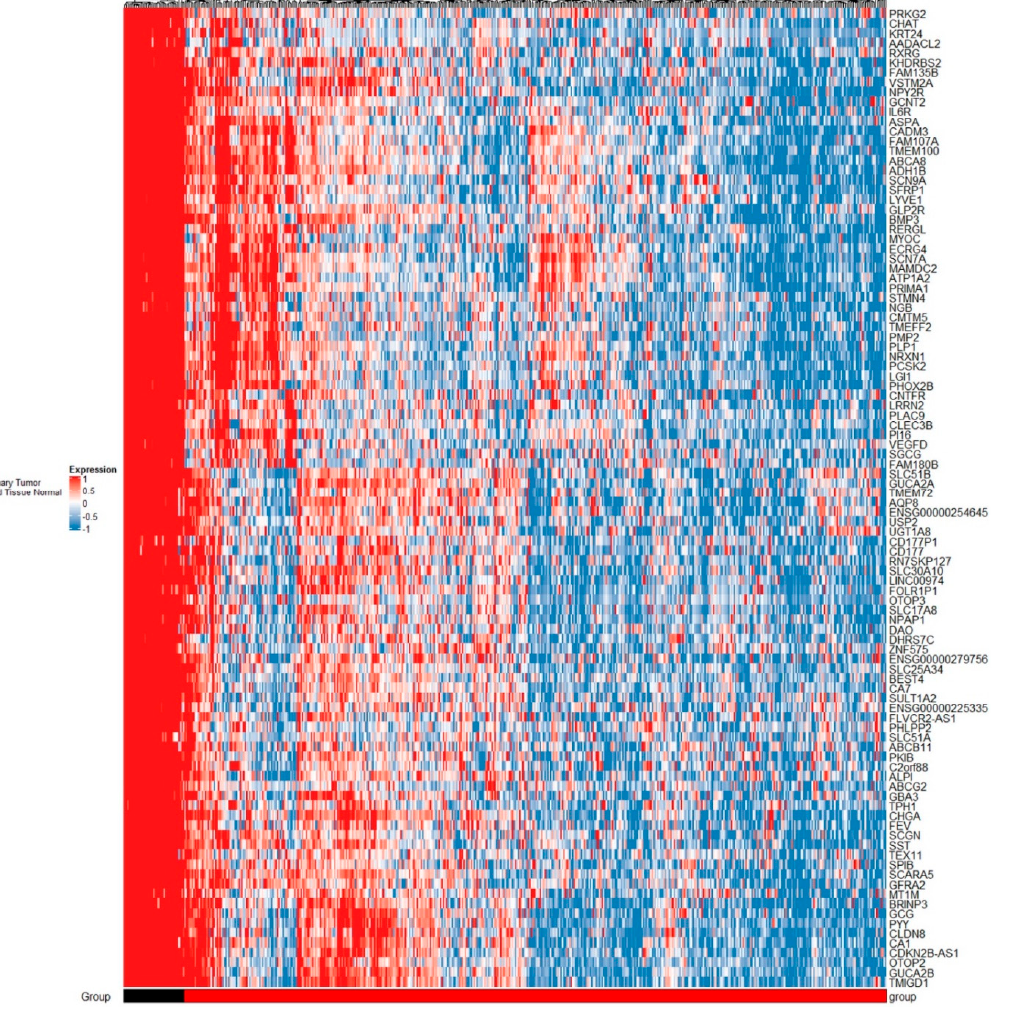
Figure 5. Top 100 DEGs heatmap of expression between the primary tumor and normal samples. Legend: group Primary Tumor, carcinoma; group Solid Tissue Normal, normal tissue; gene names, where available, otherwise Ensembl Gene identificators are shown on the right side of the heatmap; downregulation is associated with blue color, no difference in expression is associated with white color, and upregulation is associated with red